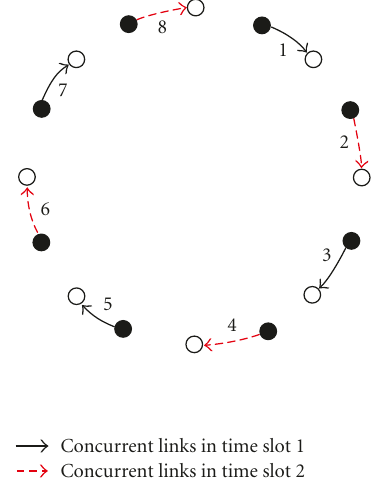
Figure 1: A ring network of 8 links is partitioned by the DCLS algo- rithm with K = 2 into two subnetworks of 4 links each. The (filled) black circles denote the transmitting nodes and the blank ones the receiving nodes.